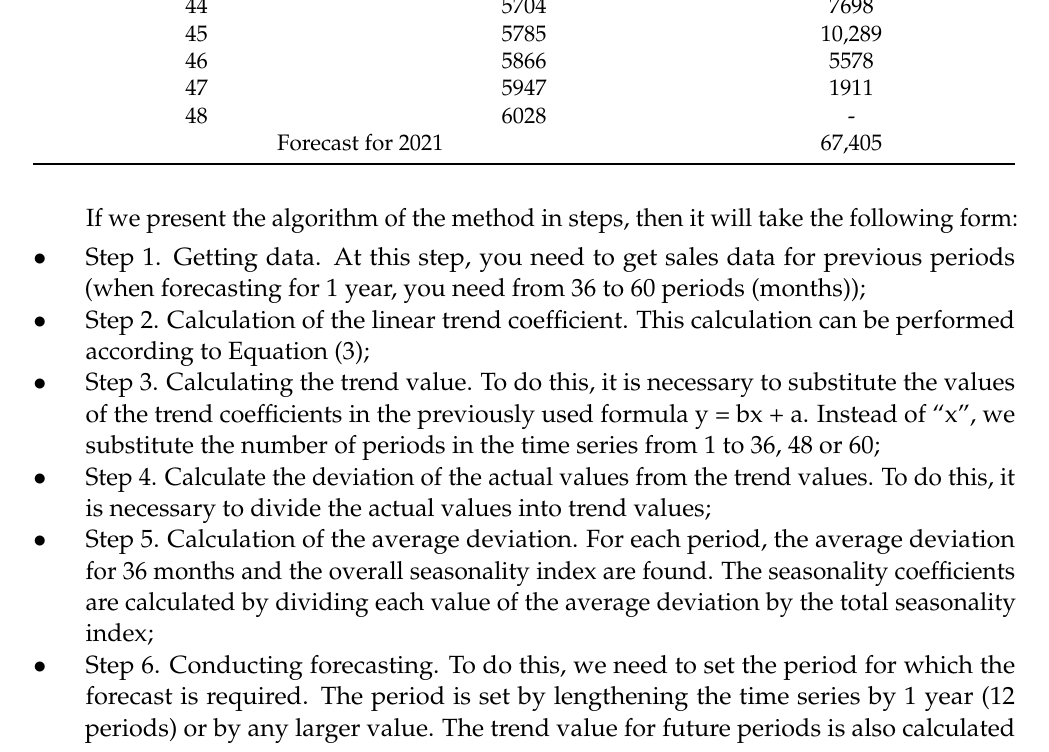
Figure 3. Seasonality coefficients, cleared from growth.